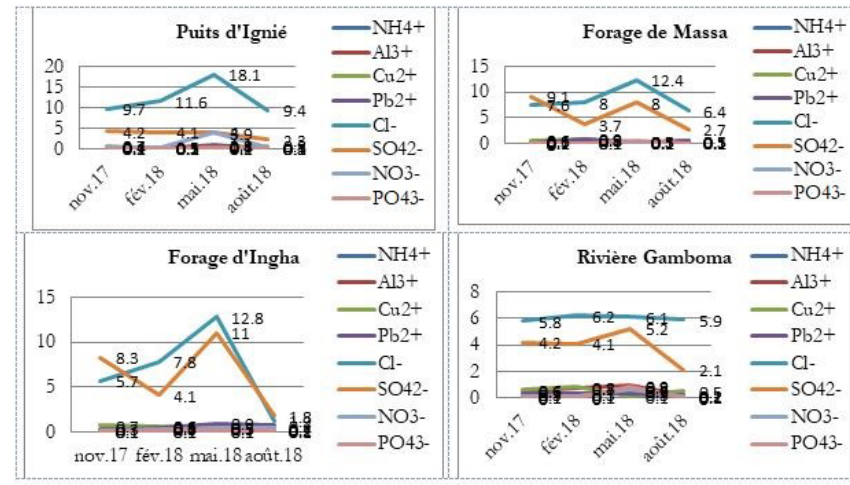
Figure 4. Variation saisonnière des métaux lourds et les polluants mesurés au cours de l’année